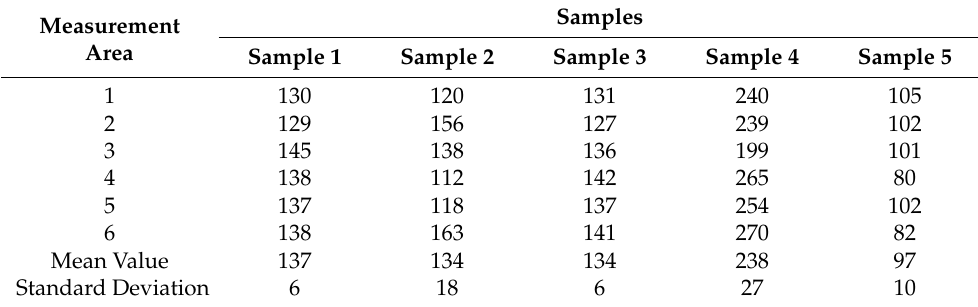
Table 5. The results of the measurements of the coating average thickness for samples in µ m. Measurement